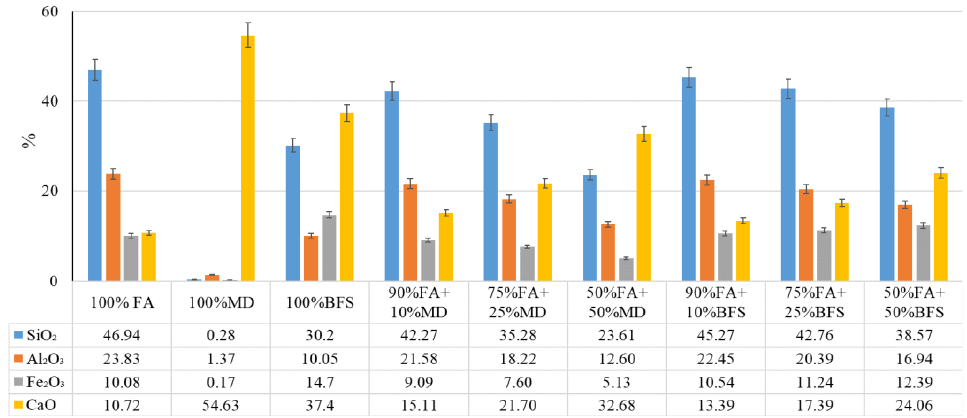
Figure 7. Geopolymer binder chemical composition for different mixtures (wt.%).